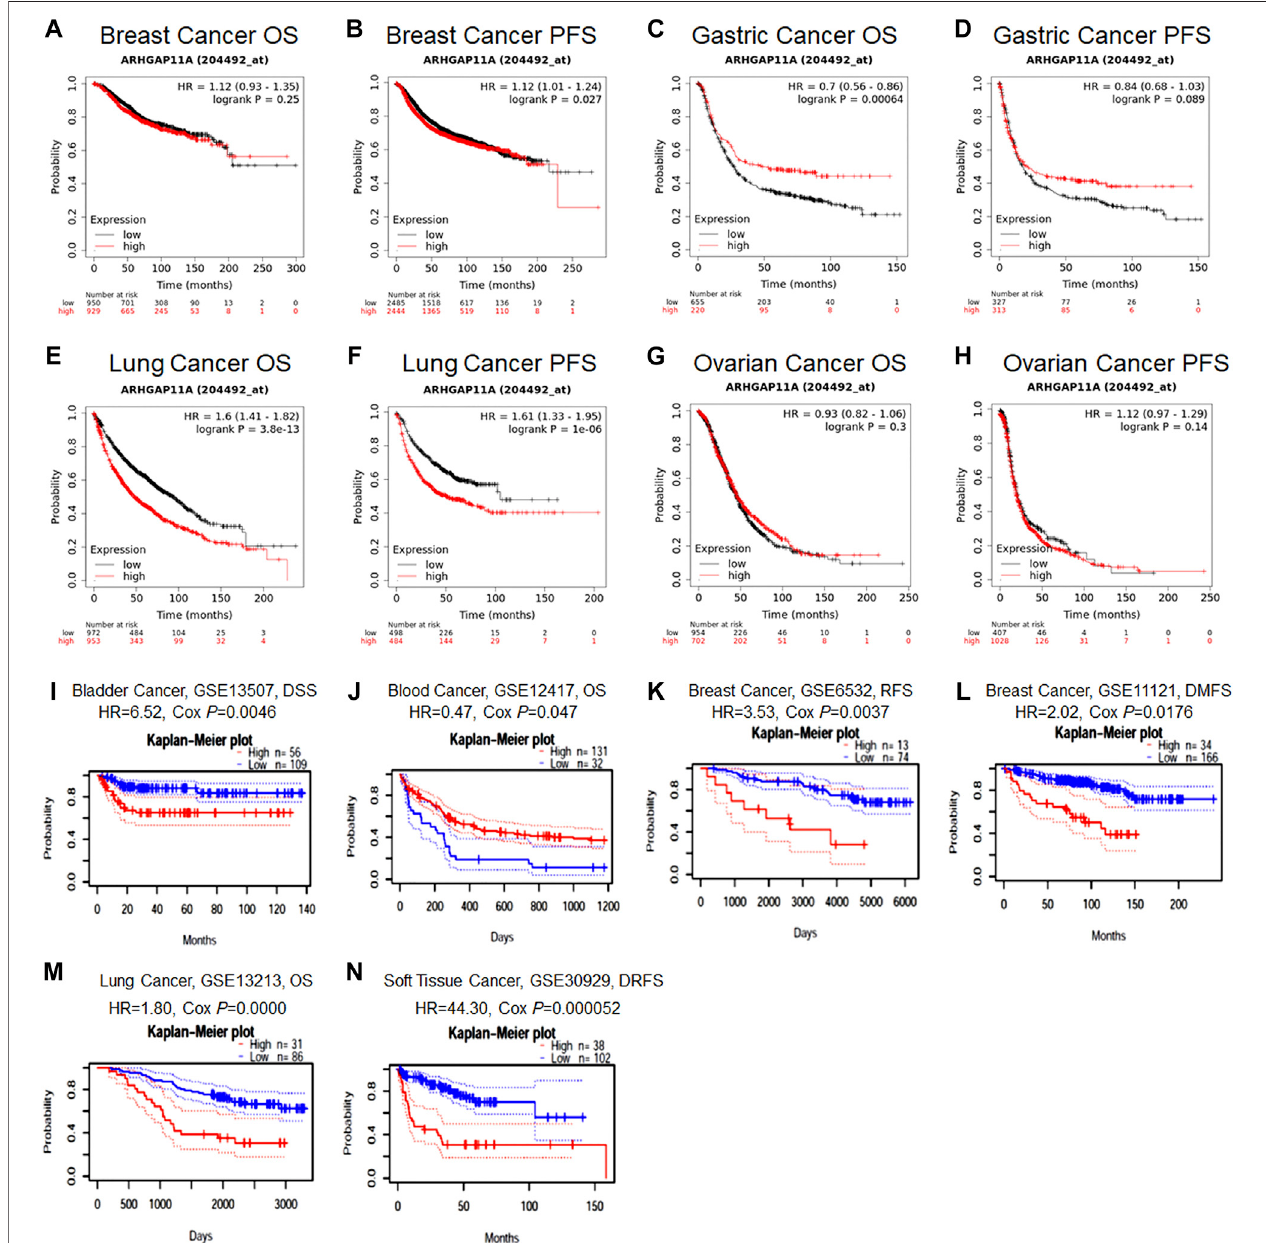
FIGURE 2 | The prognostic value of ARHGAP11A expression in various types of cancer. (A – H) Kaplan-Meier Plotter. (I – N) PrognoScan. The cohort GSE12417: expression pro fi ling by array; cancer subtype: acute myeloid leukemia; n (cid:1) 163; endpoint: overall survival. The cohort GSE13213: expression pro fi ling by array; cancer subtype: lung adenocarcinoma; n (cid:1) 117; patient age: 32 – 84 years old; endpoint: overall survival. The cohort GSE13507: expression pro fi ling by array; cancer subtype: bladder transitional cell carcinoma; n (cid:1) 165; patient age: 27 – 88 years old; sample type: frozen tissue; endpoint: disease speci fi c survival. The cohort GSE6532: expression pro fi ling by array; cancer subtype: breast cancer; n (cid:1) 87; endpoint: distant metastasis free survival. The cohort GSE11121: expression pro fi ling by array; cancersubtype:breastcancer;n (cid:1) 200;patientage:34 – 89yearsold;sampletype:frozen;endpoint:distantmetastasisfreesurvival.ThecohortGSE30929:expression pro fi ling by array; cancer subtype: liposarcoma; n (cid:1) 140; endpoint: distant recurrence free survival.